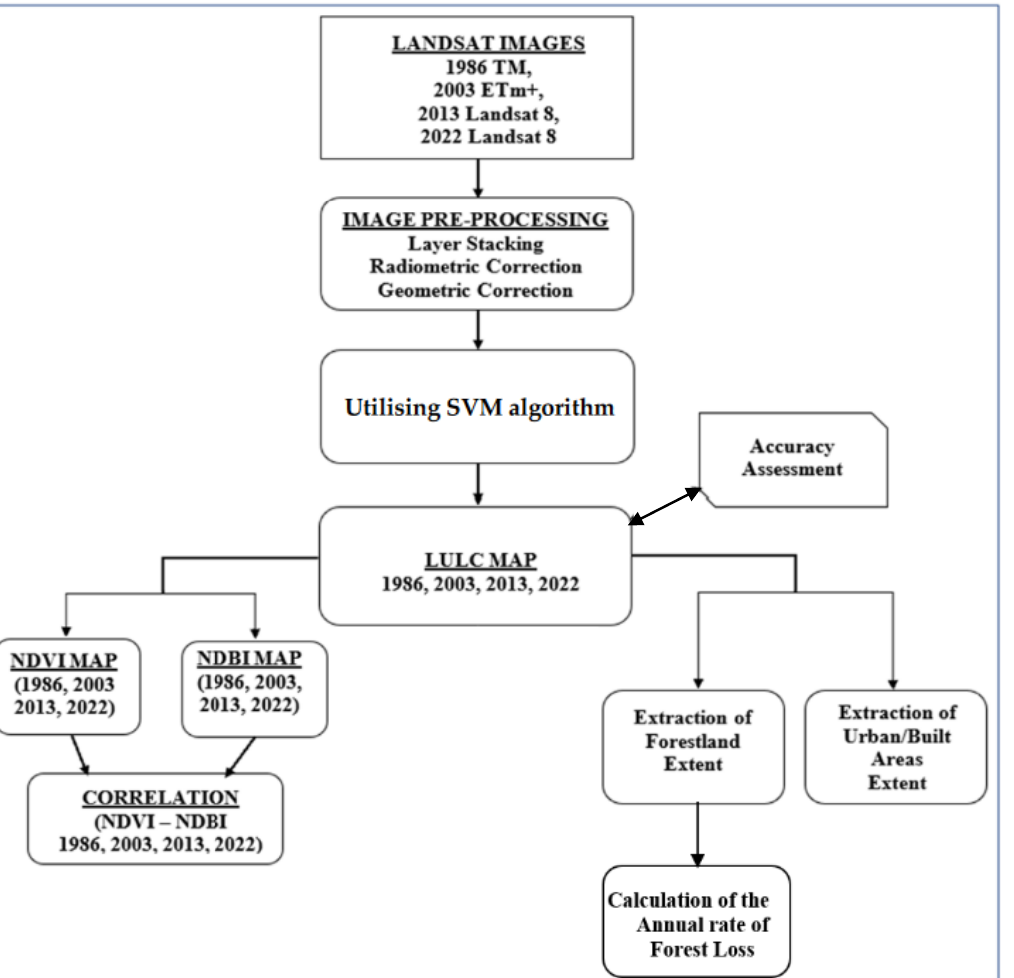
Figure 2. Flowchart of the methodology utilised for the study.